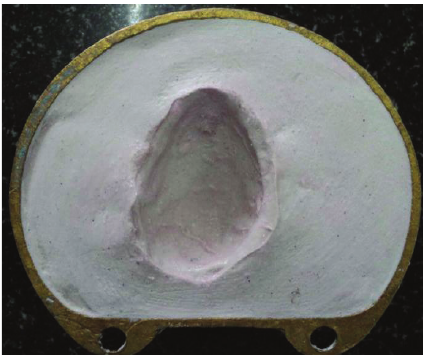
Figure 7: Dewaxing of waxed-up bulb.